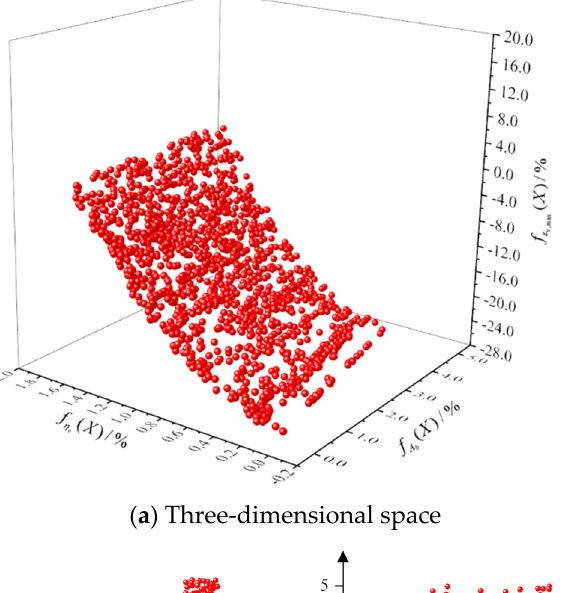
Figure 14. Flowchart for solving the multiobjective optimization problem of grain.